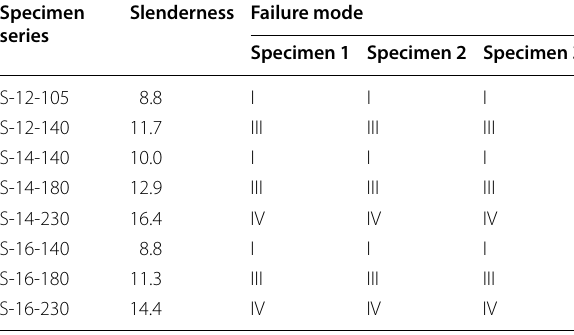
Table 2 Specimen failure patterns Specimen series